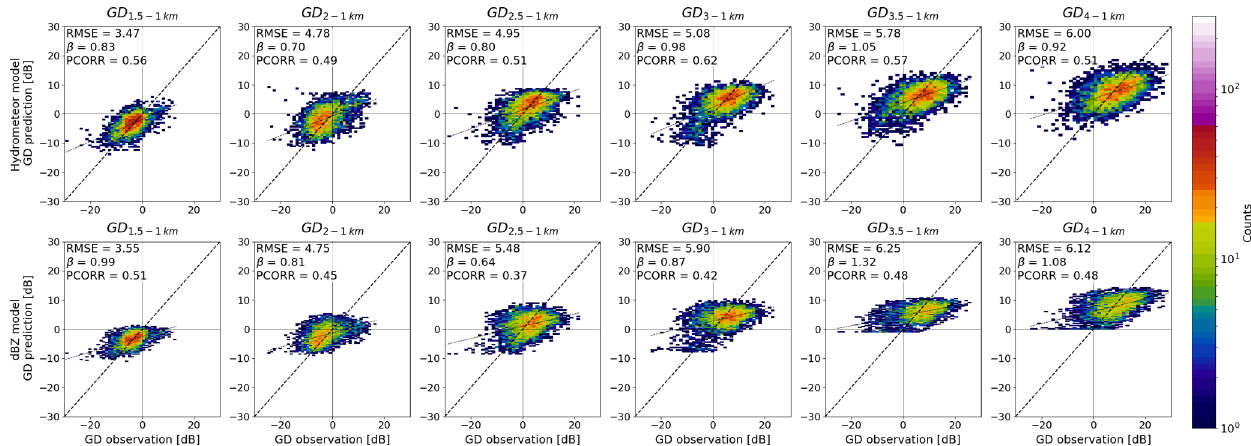
Figure 5. The 2-D histograms for observed ( x axes) and predicted ( y axes) GD for the HC + dBZ models (top row) and dBZ-only models (bottom row) trained with data starting from higher altitude levels and aloft (columns). The number of points in each bin is indicated in colour.